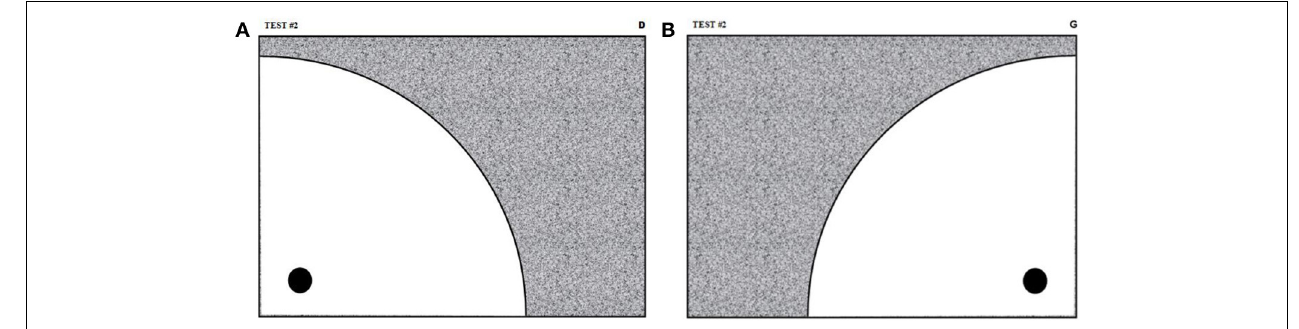
FIGURE 3 | Guiding sheets for the fast pen stroke test with simple stimulus. The black circles and the gray areas indicate respectively the starting and the target zones. This sheet in (A) is used for right-handed